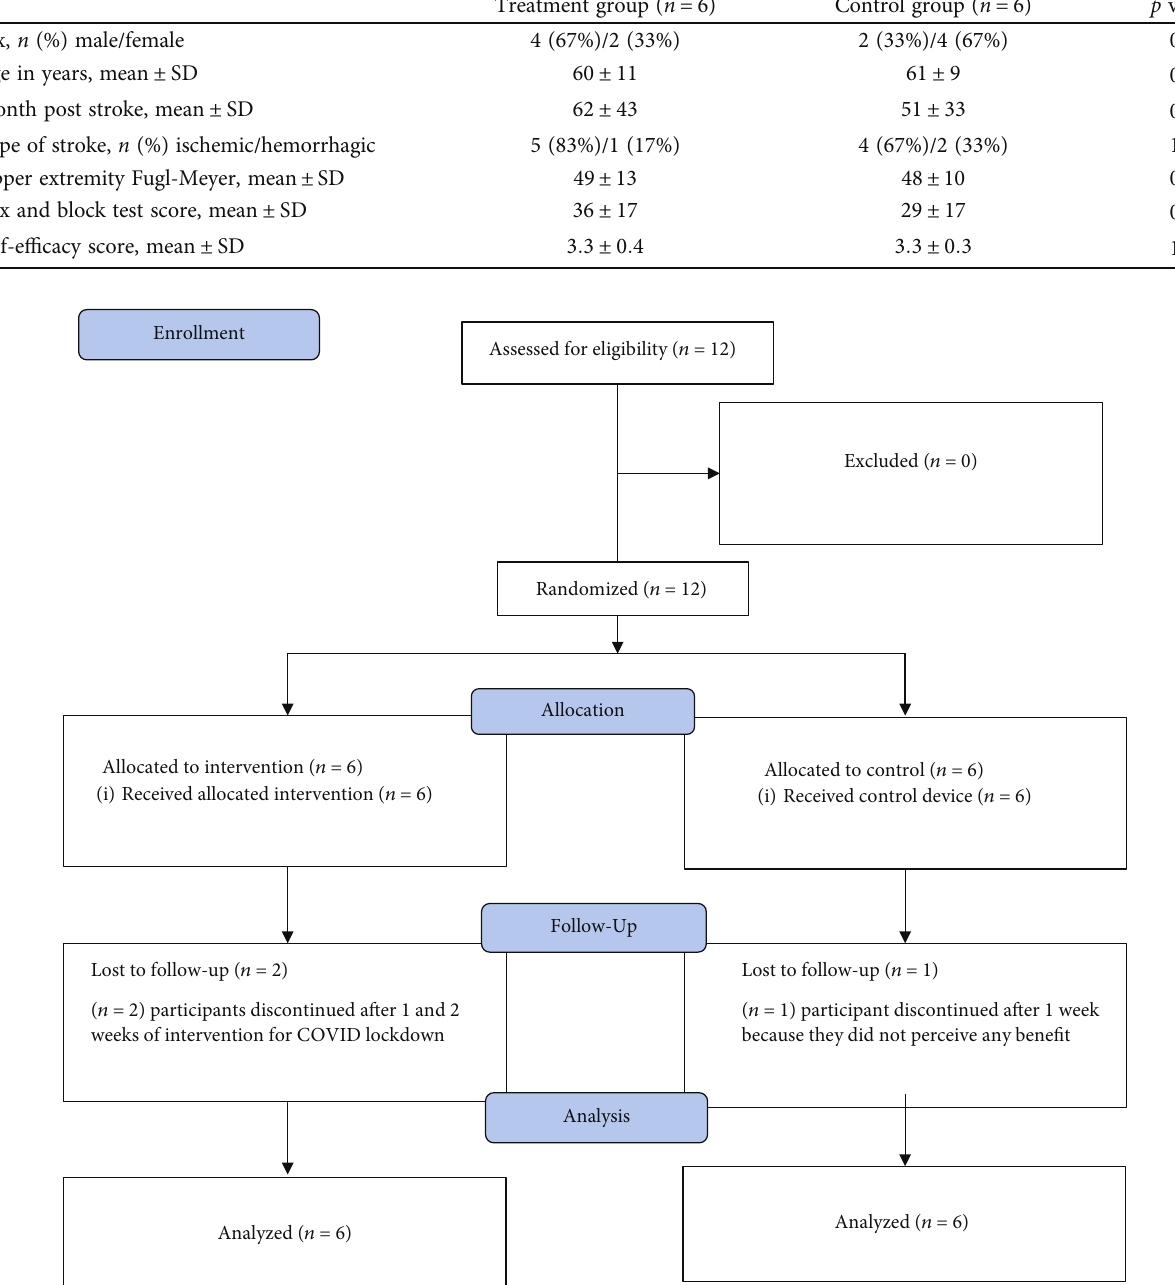
Table 2: Baseline characteristics.